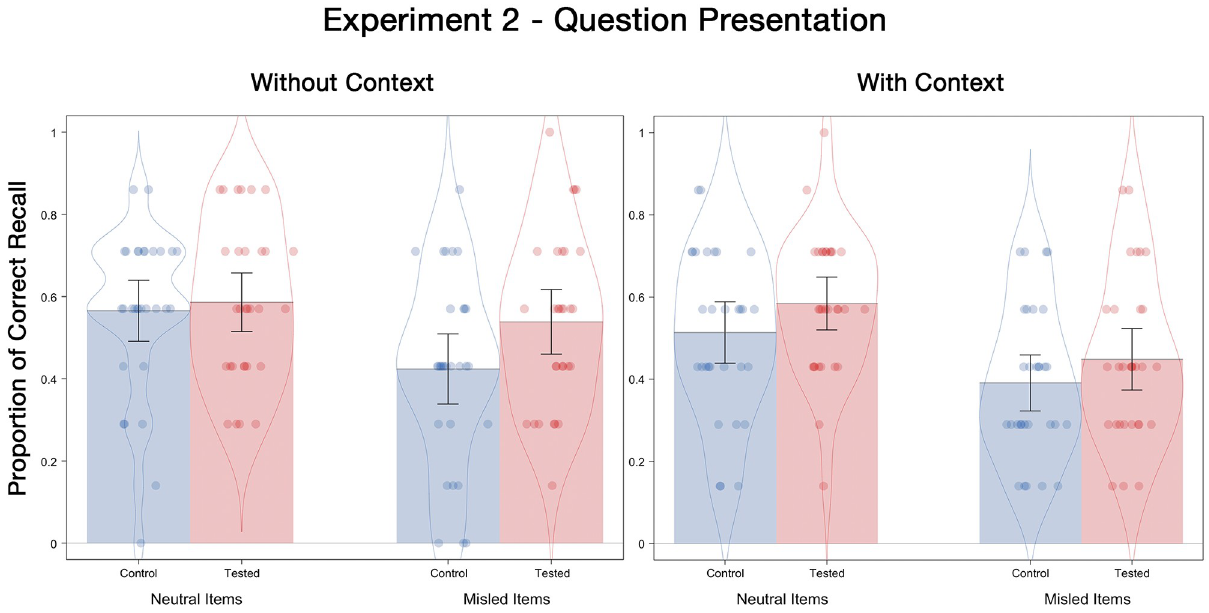
Fig 3. Correct recall probabilities for neutral and misled items as a function of the presence or absence of contextual details on the final test of Experiment 2. Error bars indicate descriptive 95% confidence intervals.